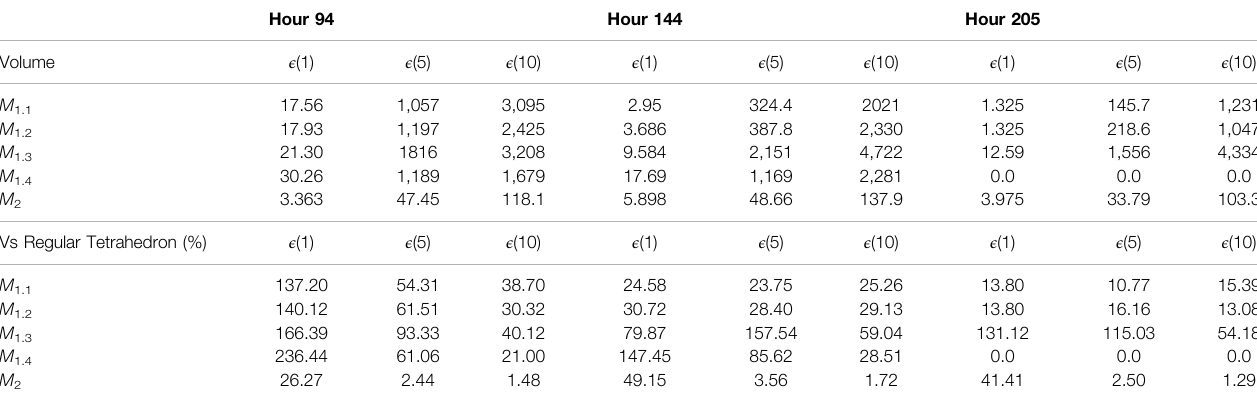
TABLE 2| Volumes (in units of10 6 km 3 ) with reconstructed magnetic fi eld error less than 1, 5, or 10% for the three con fi gurations using the four fi rst-order methods and the second-order method discussed in §2.2. These volumes are compared to the equivalent regions reconstructed from a single regular tetrahedron with the same characteristic size as the overall nine-spacecraft con fi guration. Hour 94 Hour 144 Hour 205